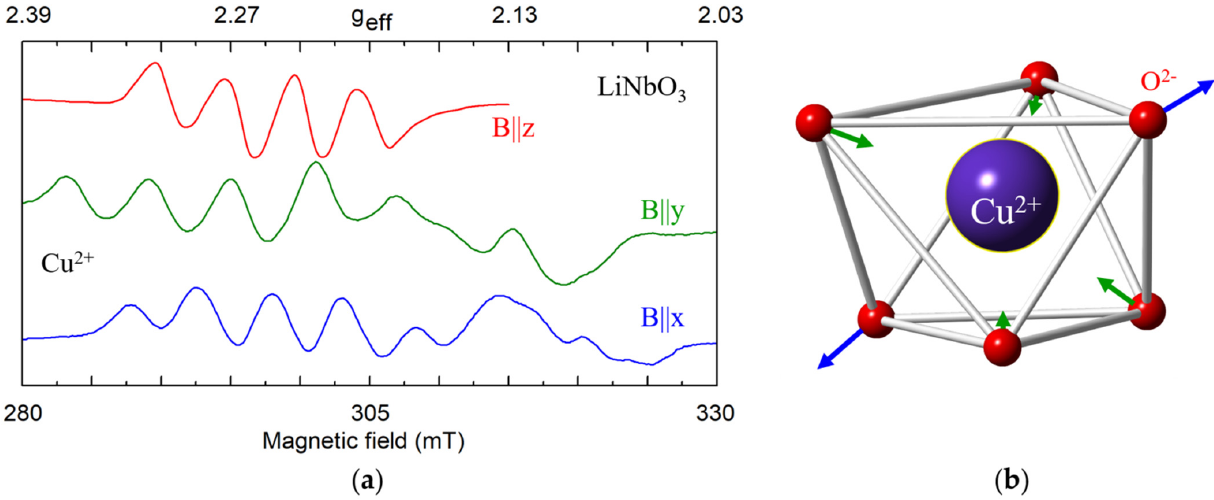
Figure 11. ( a ) Measured EPR spectrum of Cu 2+ in LN, X-band, T = 7 K. ( b ) Distortion of oxygen octahedron due to Jahn-Teller effect.